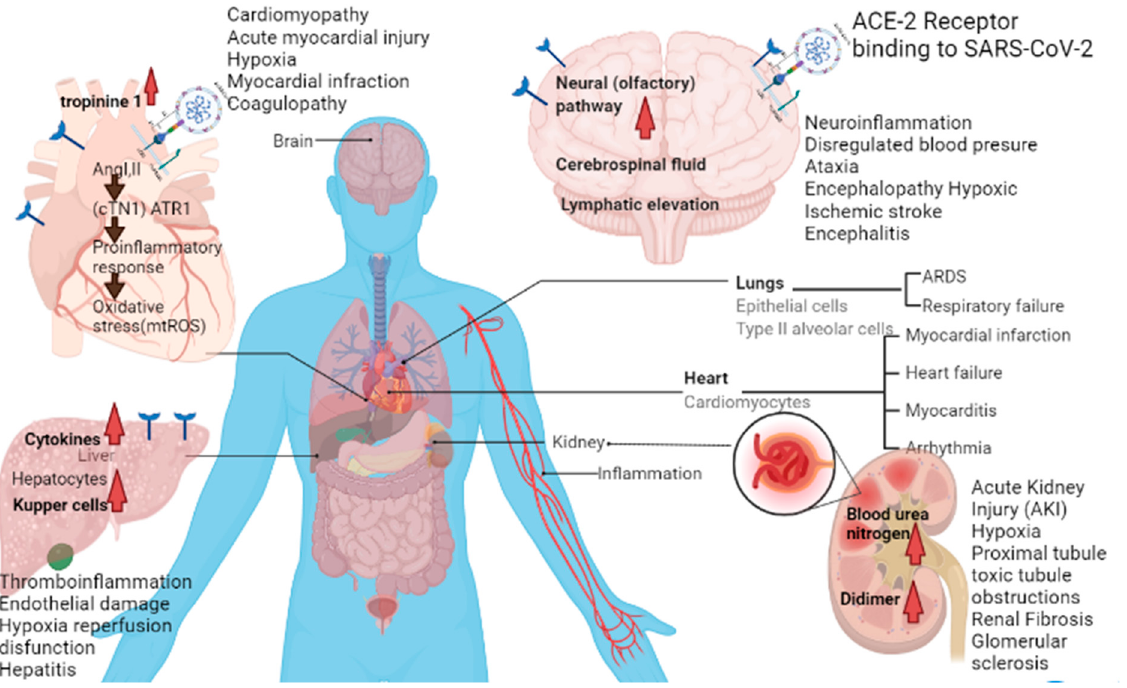
Figure 3. Post-COVID-19 conditions that may occur in different organs. Table 2. Post-COVID conditions with their phytotherapy.